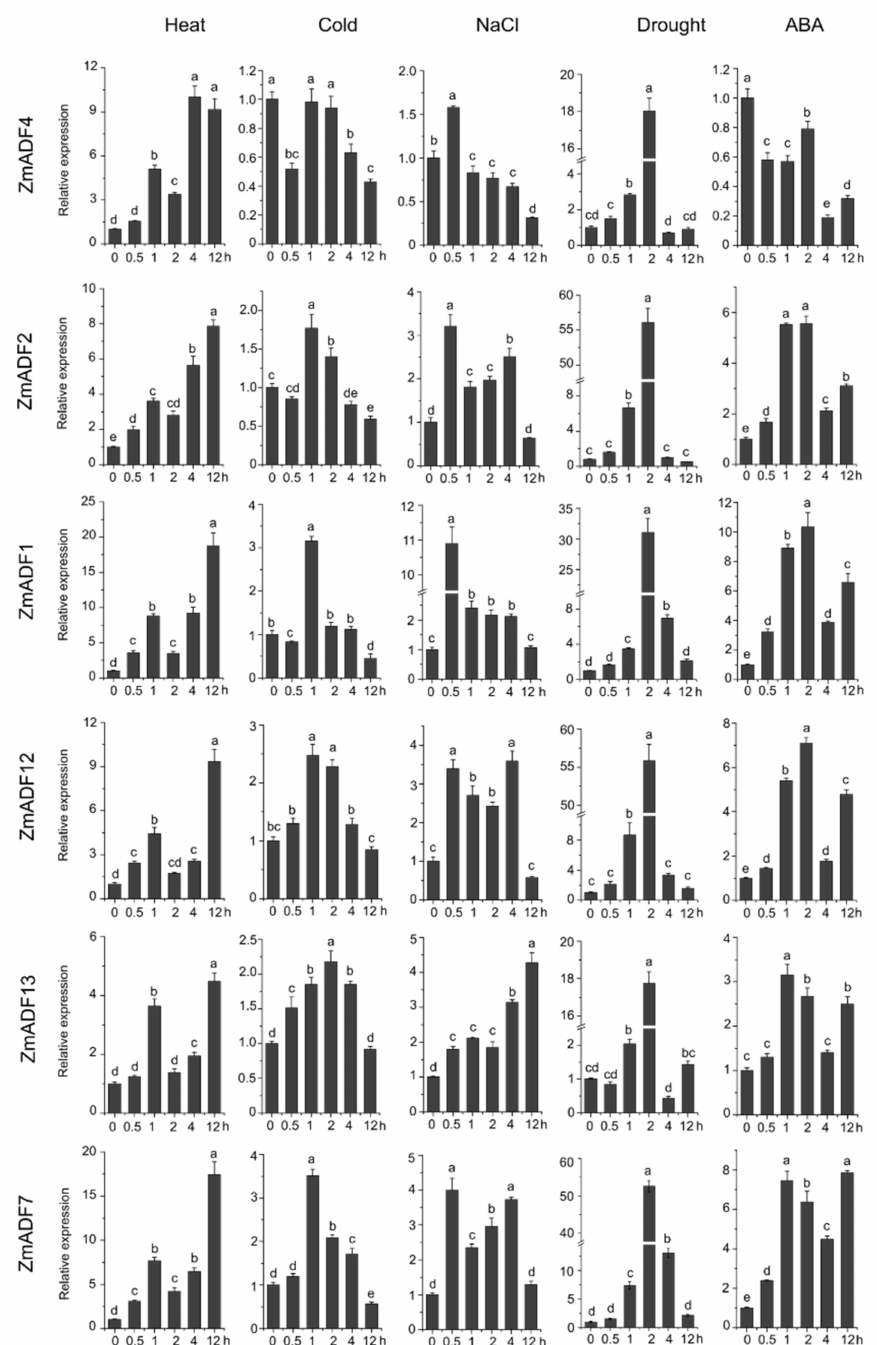
Figure 6. Relative expression levels of ZmADFs under heat (40 ◦ C), cold (4 ◦ C), salinity (0.2 M NaCl solution), drought, and abscisic acid (0.1 mM ABA) treatments in maize. qRT-PCR was used to study the expression level of 13 ZmADF genes. The internal reference gene is ZmActin . Three independent experiments were conducted. The abscissa represents the time point after stress treatment. Vertical bars indicate the standard error of mean. Small letter(s) above the bars indicated significant di ff erences ( p < 0.05, Duncan) between time